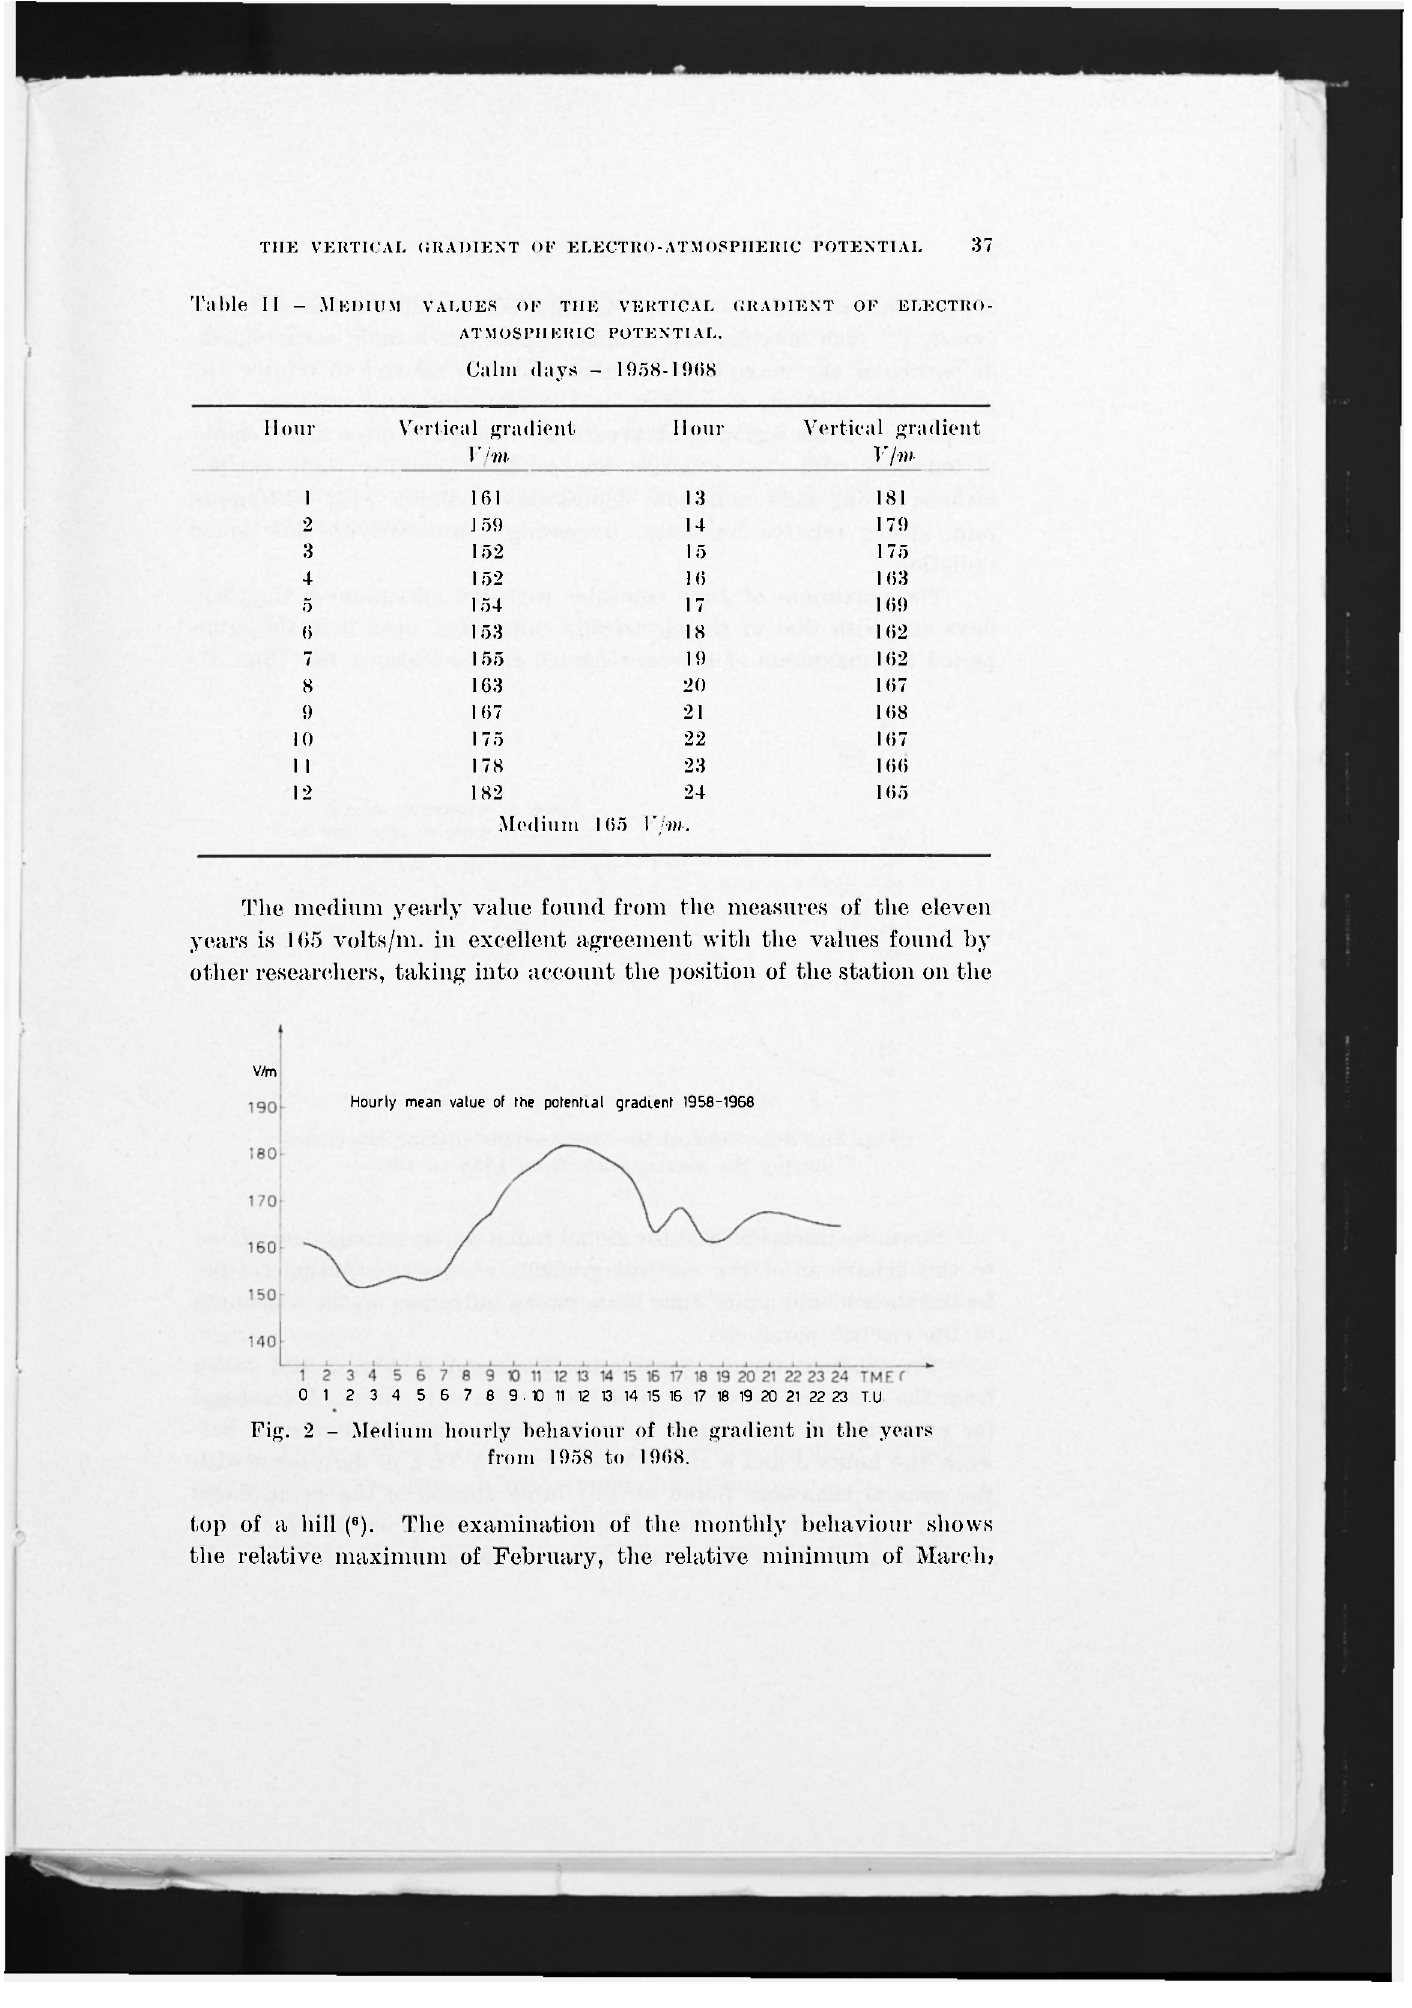
MEDIUM VALUES OF THE VERTICAL GRADIENT OF ELECTRO- ATMOSPHERIC POTENTIAL.